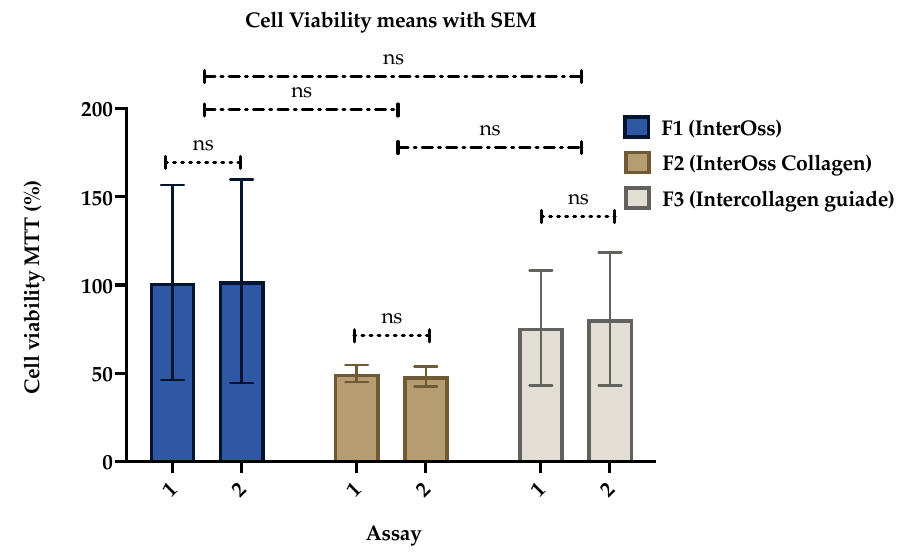
Figure 8. Mean and standard error of cell viability MTT for the xenografts.